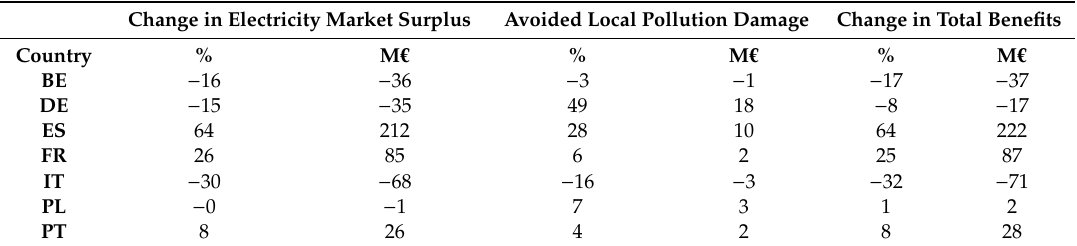
Table 8. The breakdown of the ALPD, and the change in EMS and TB, for selected countries for Vision 3 in